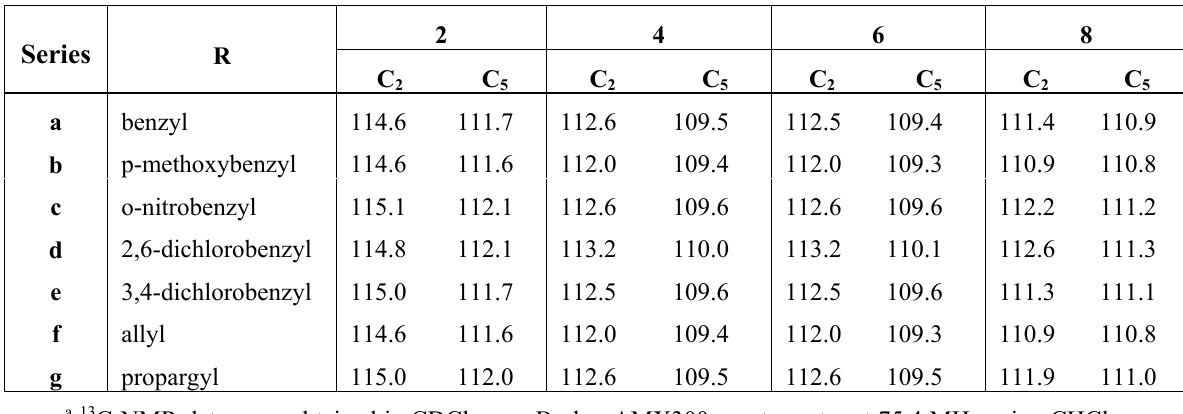
Table 2. 13 C-NMR Data